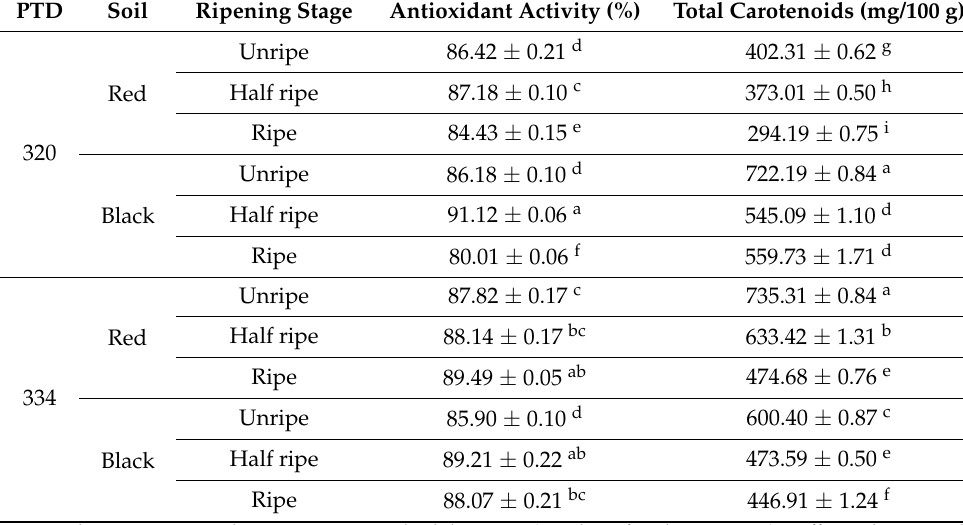
Table 2. Total carotenoids and antioxidant activity (DPPH) in unripe (green pepper), half ripe (green- orange pepper) and ripe (orange pepper) Habanero pepper ( Capsicum chinense Jacq.) cultivated in different soils. PTD Soil Ripening Stage Antioxidant Activity (%) Total Carotenoids (mg/100 g)